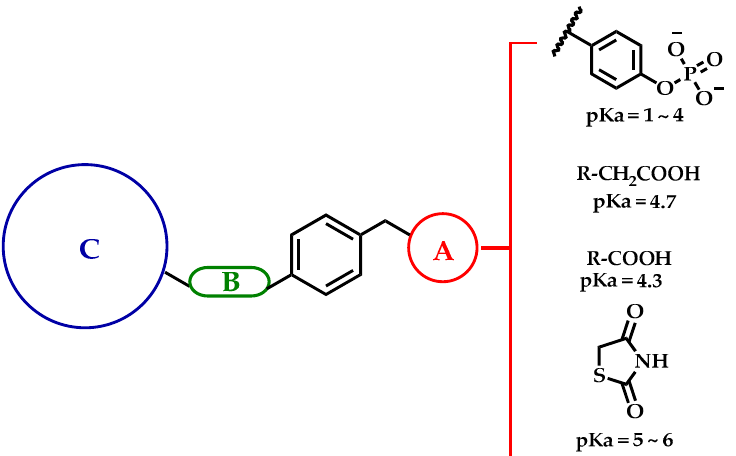
Figure 1. Unified antidiabetic pharmacophore proposed with multitarget activity on PPAR α , PPAR γ , GPR40, aldose reductase (AR), and PTP-1B: (A) acid group, (B) flexible linker, (C) bulky hydrophobic group, and a central phenyl core. A pKa comparison between acid bioisosteric groups used to design these molecules is also